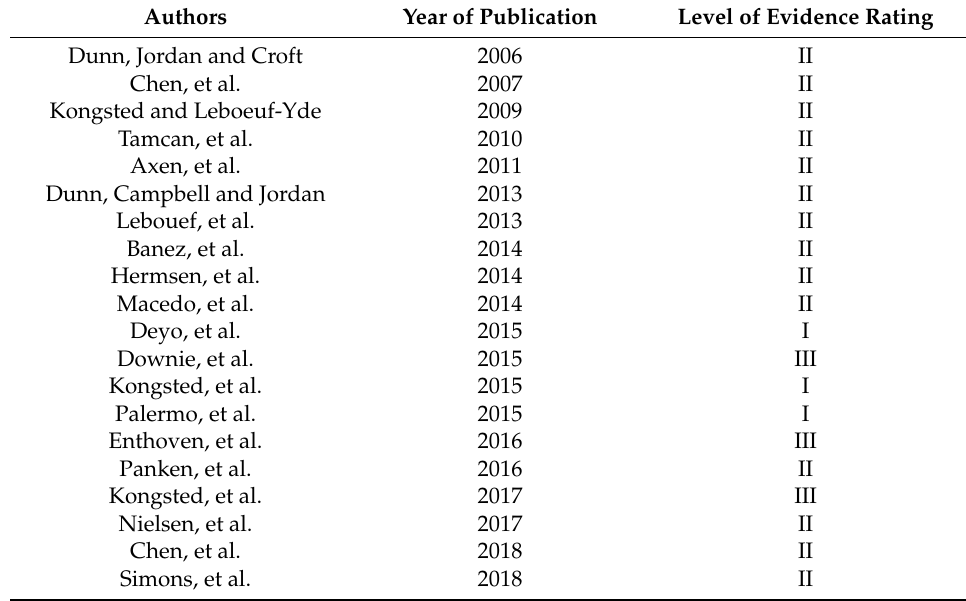
Table 2. Levels of Evidence Ratings of Included Trajectory Studies